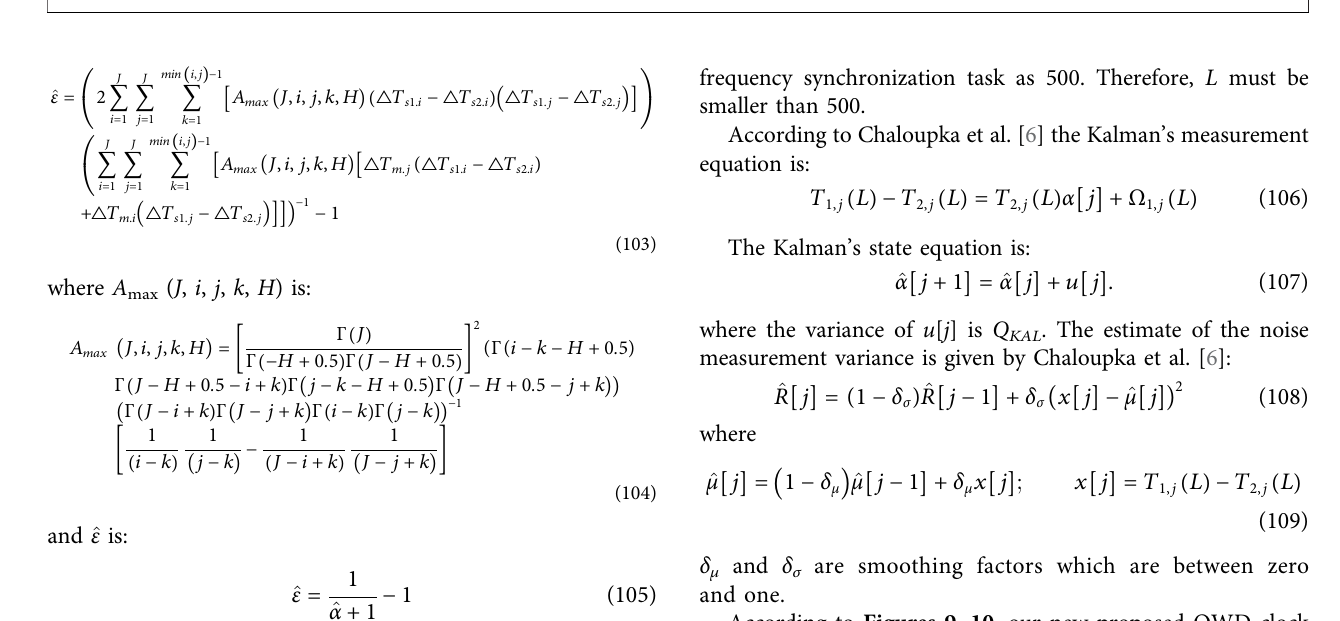
(cid:2) 0 . 1 e − 3 [ sec ] . 2